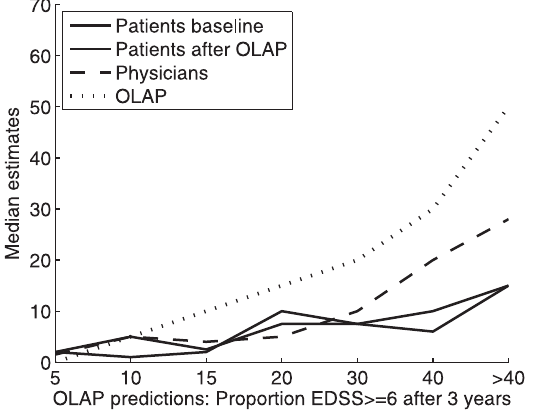
Figure 2. Estimates for EDSS $ 6 after 3 years. Mean estimates by patients at baseline and after exposure to the OLAP tool and by physicians, in relation to the OLAP tool’s estimates are given. Median estimates for each of the groups can be read off the y-axis in relation to the predictions made by the OLAP tool (x-axis; binned into 7 categories, therefore not exactly bisecting the angle of x- and y-axis).